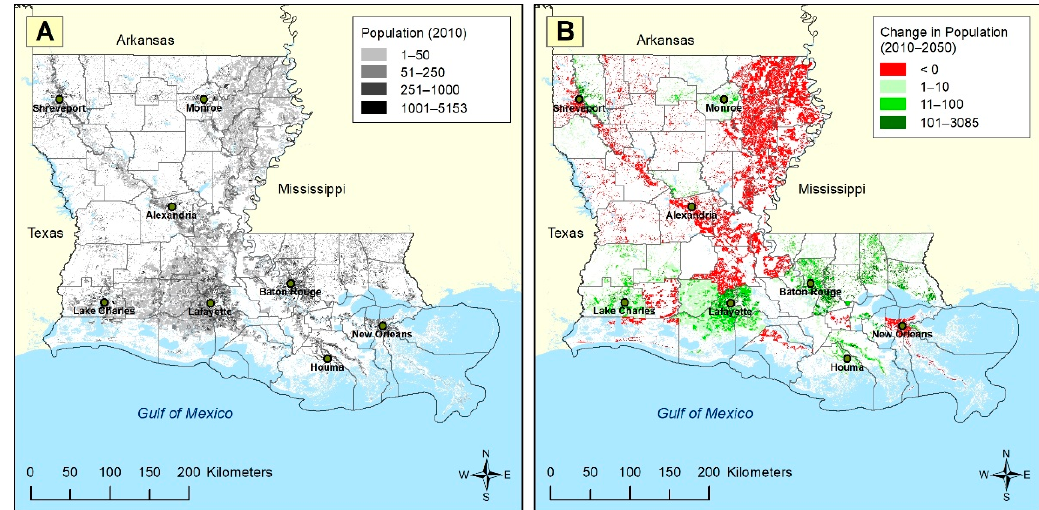
Figure 2. Population by census block: ( A ) 2010, and ( B ) change in population from 2010 to 2050.